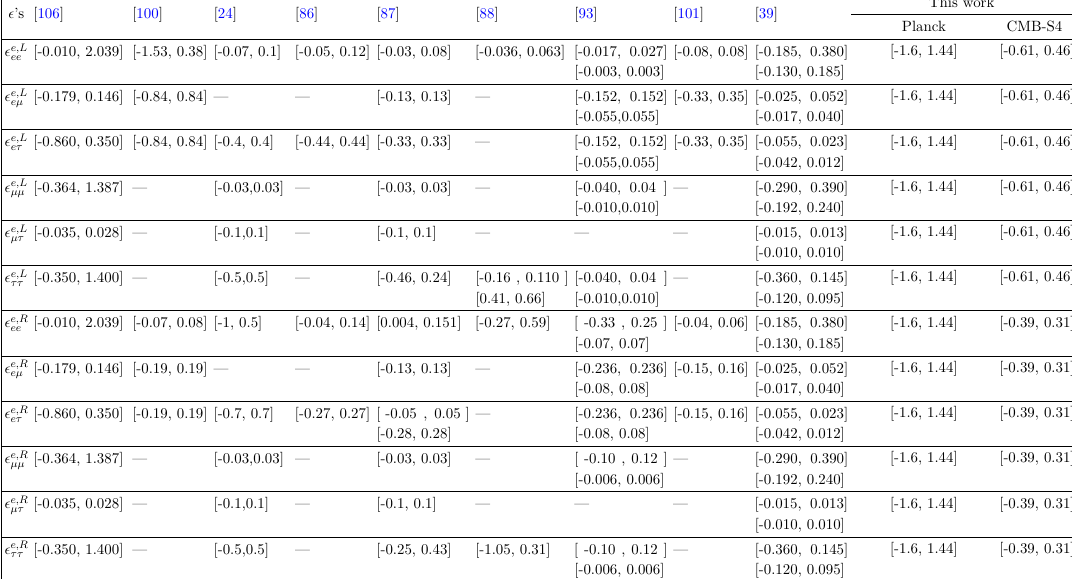
Table 4 . Summary of constraints on dimension-6 neutrino-electron NC NSIs from previous studies and this work. Constraints from a global fitting of all kinds of neutrino oscillation data plus the COHERENT result are obtained in ref. [106], the TEXONO collaboration in ref. [100], the LEP, LSND and CHARM-II experiments in ref. [24], a global analysis of ν LSND, Irvine, Rovno and MUNU experiments in ref. [86], OPAL, ALEPH, L3, DELPHI, LSND, CHARM-II, Irvine, Rovno and MUNU experiments in ref. [87], solar and reactor neutrino experi- ments in ref. [88], low-energy solar neutrinos at source and detector from the Borexino experiment in ref. [93], a global analysis of short baseline νe and ¯ νe data from LSND, LAMPF, Irvine,